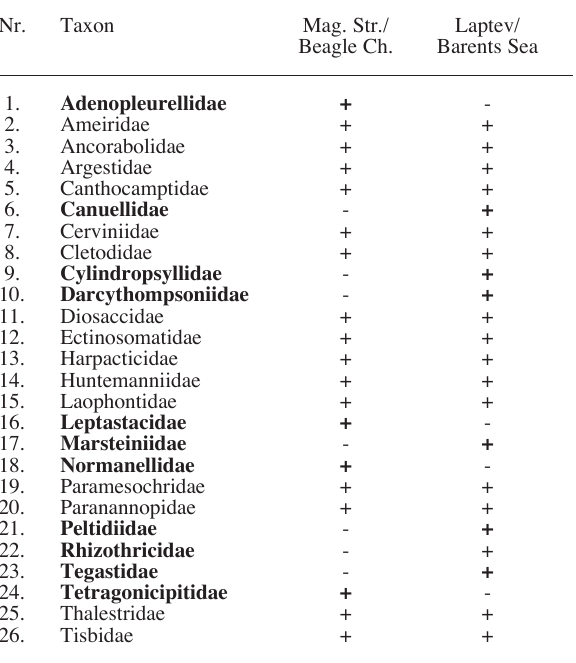
ABLE 3. – List of harpacticoid genera found in the Magellan Straits and/or Beagle Channel. + = present, - = absent. Taxa restricted to one of the areas indicated by bold names and symbols. Genera marked with an asterisk* are new for the Chilean marine fauna. Nr. Taxon